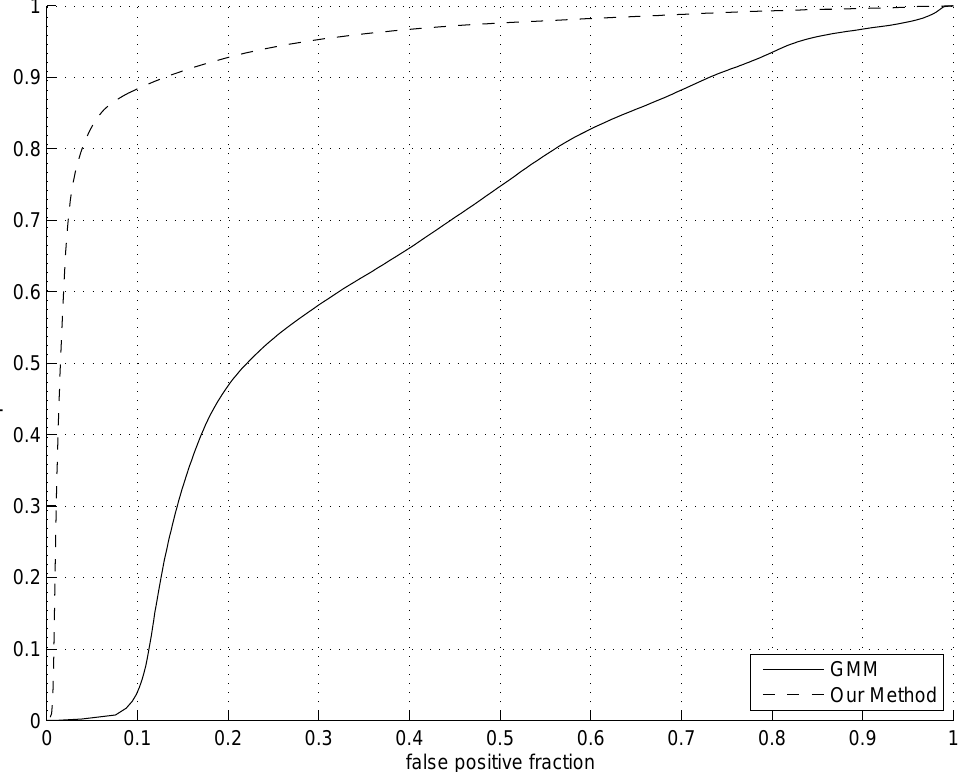
Figure 9. The receiver operating characteristic (ROC) curves: the dashed line is ROC curve of our method, the other one is ROC curve of the GMM-based